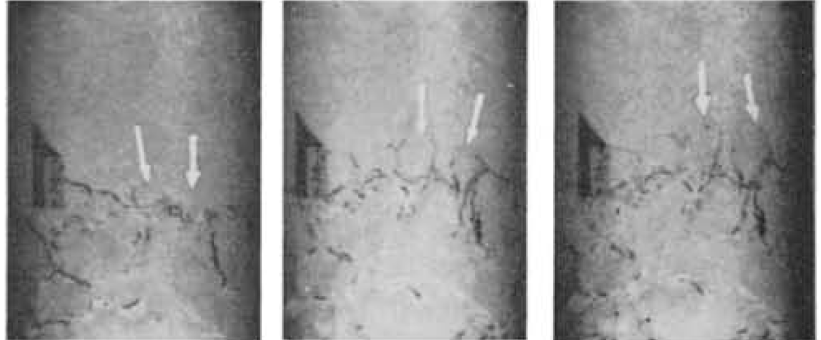
Figure 3. Visualization of entrainment due to break-up of ripples on top of a disturbance wave in a horizontal rectangular duct in the x - y plane [38].